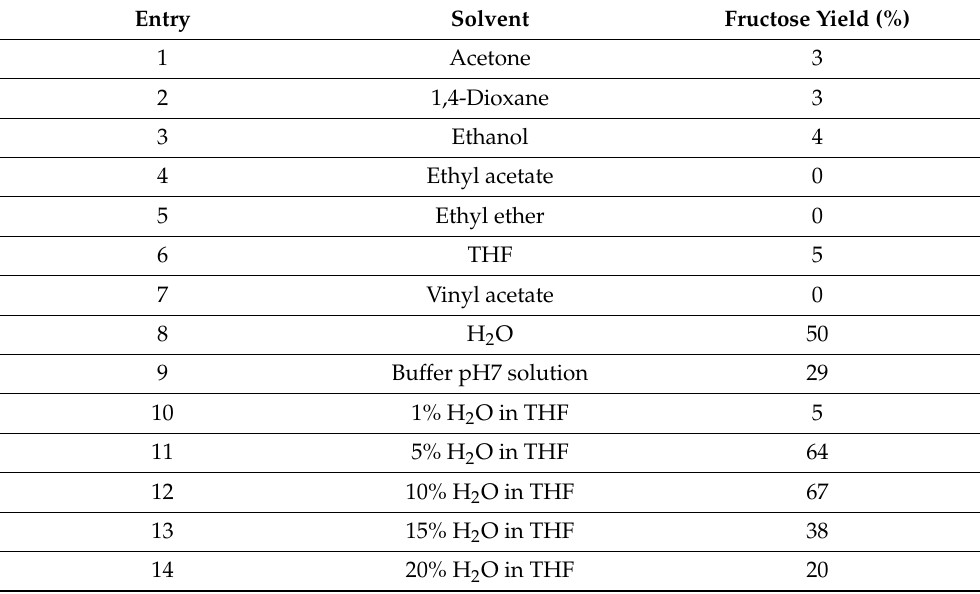
Table 1. Enzymatic isomerization in several solvents.